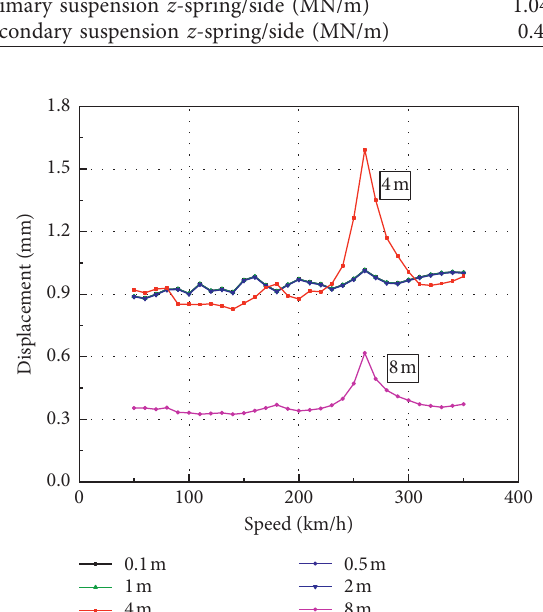
Figure 5: The maximum midspan displacement of the bridge under different sizes of the bridge